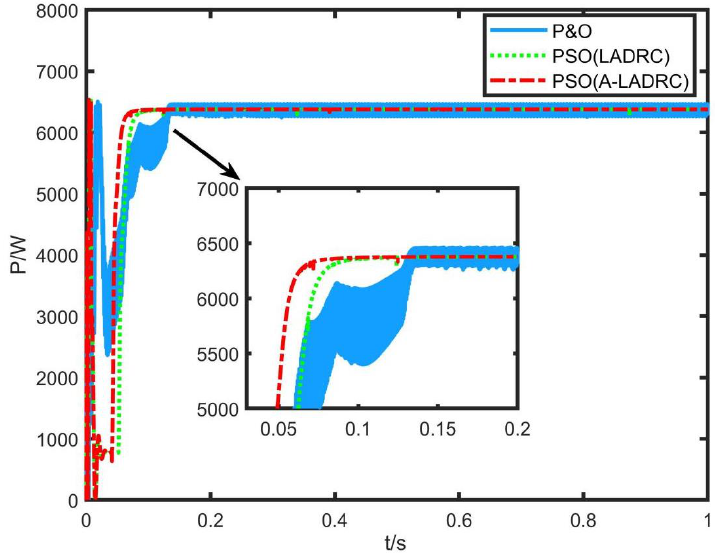
Figure 5. Output power of photovoltaic array under uniform illumination.